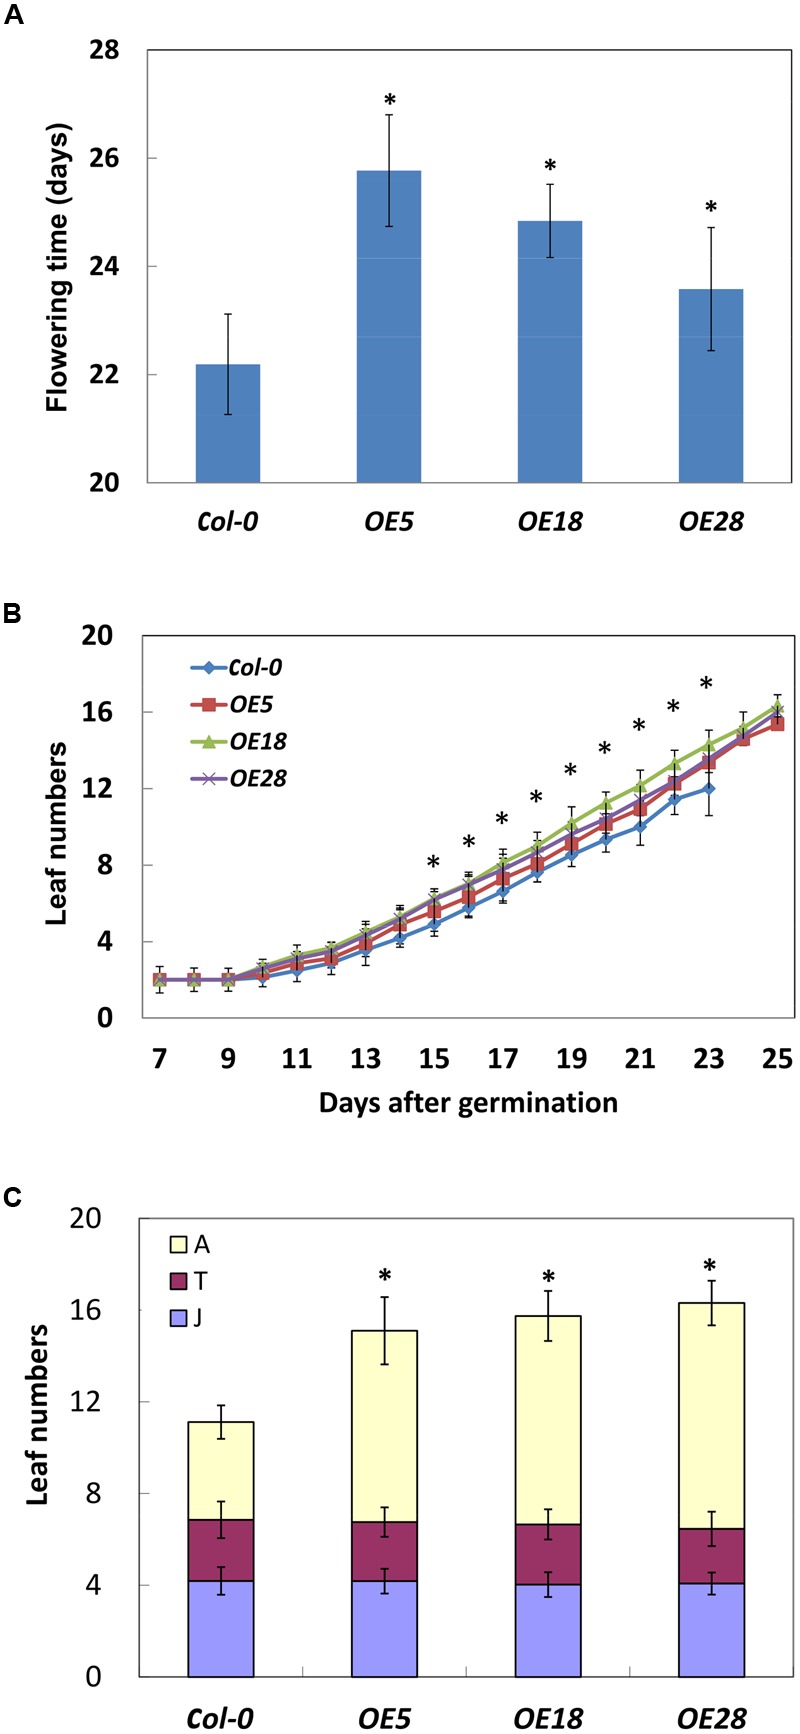
HbEBP1 overexpression delayed the vegetative-to-reproductive transition in Arabidopsis. (A) Days needed for the Col-0, OE5, OE18 and OE28 plants to produce visible flower meristems. (B) The leaf emergence rate is faster in the OE5, OE18 and OE28 lines than in Col-0 plants. Leaf numbers were counted daily with naked eyes. (C) The number of rosette leaves in the phases of juvenile (J), juvenile-to-adult transition (T) and adult (A) leaves in the Col-0, OE5, OE18 and OE28 lines. Data were presented as mean ± SEM from at least twenty individual seedlings. Student’s t-test was carried out for statistical analysis. Significant difference was defined by ∗p < 0.05.